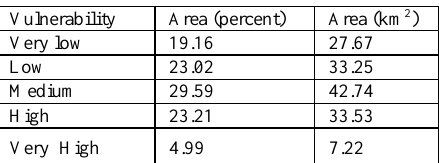
Table 2: The area of the vulnerability classes in the